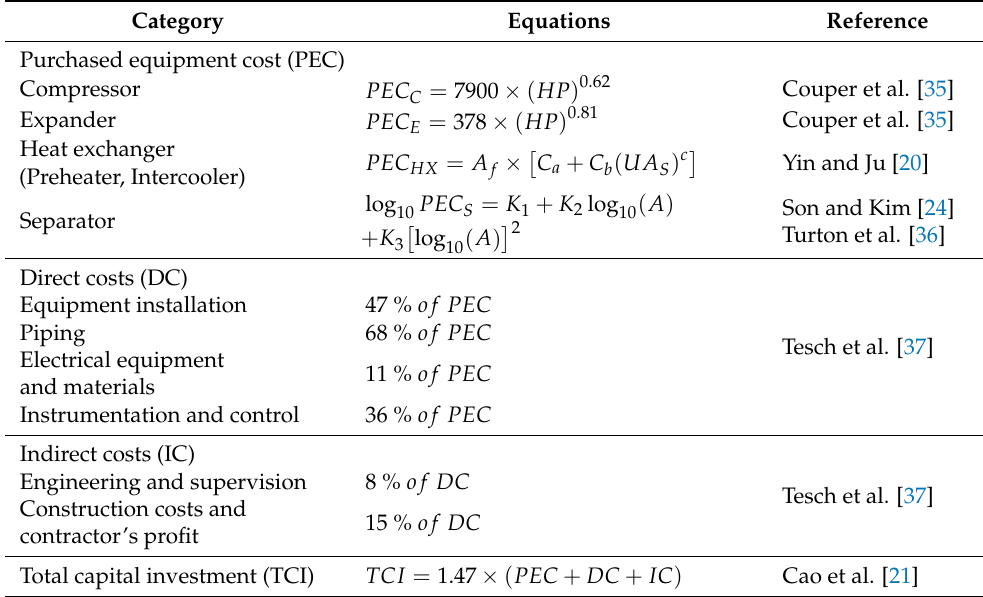
Table 3. Equations of total capital investment for the BOG re-liquefaction systems